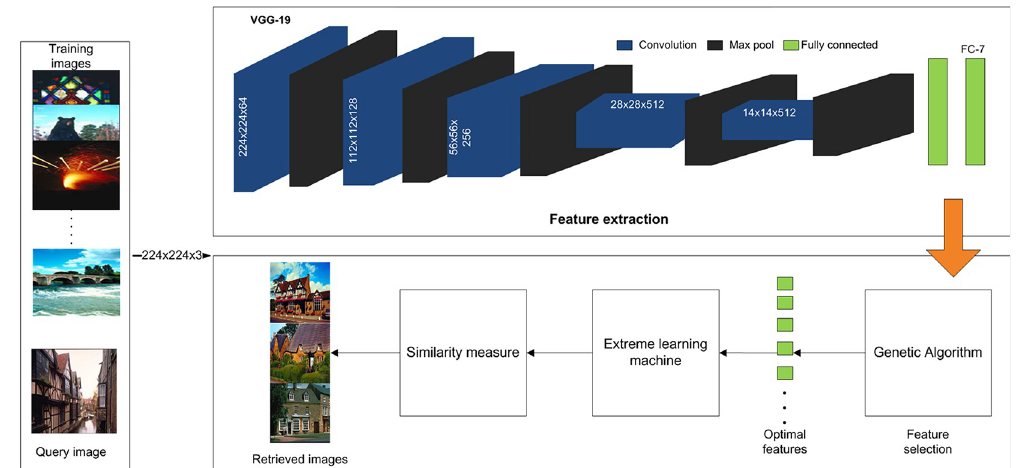
Fig 2. A proposed methodology for CBIR (reprinted from [3] under a CC BY license, with permission from J. Z. WANG, original copyright